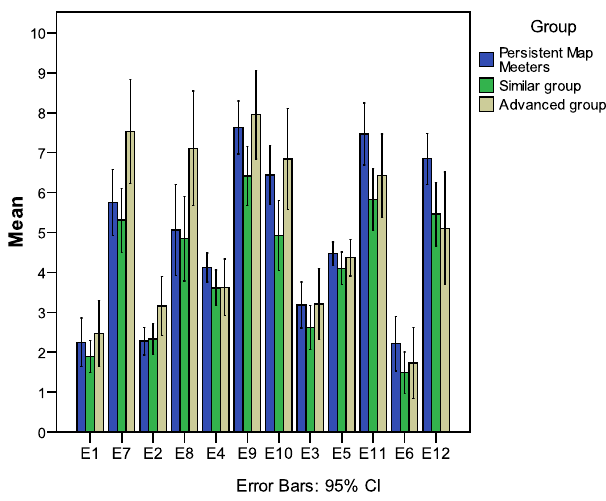
FIG. 10. (cid:1) Color online (cid:2) The exam broken down by questions. The topics covered in the exam are displayed in the sequence they were covered in the map meetings (cid:1) cf. Table IV (cid:2) , such that the x axis represents a timelike scale. Note that the persistent map meeters improve with respect to the similar and advanced groups as the semester